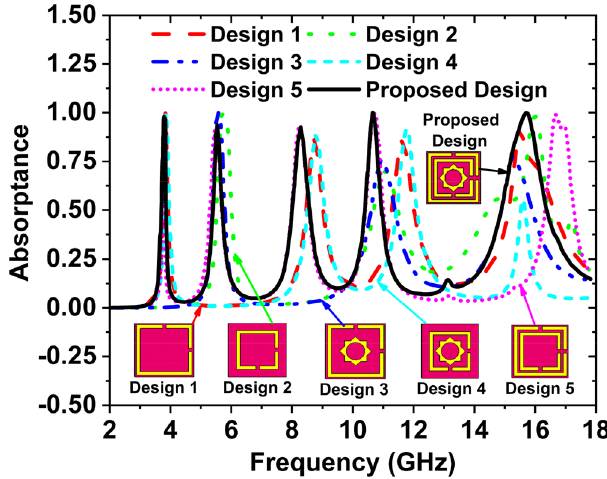
Figure 4. Change of absorption and resonance frequency due to the different design steps.